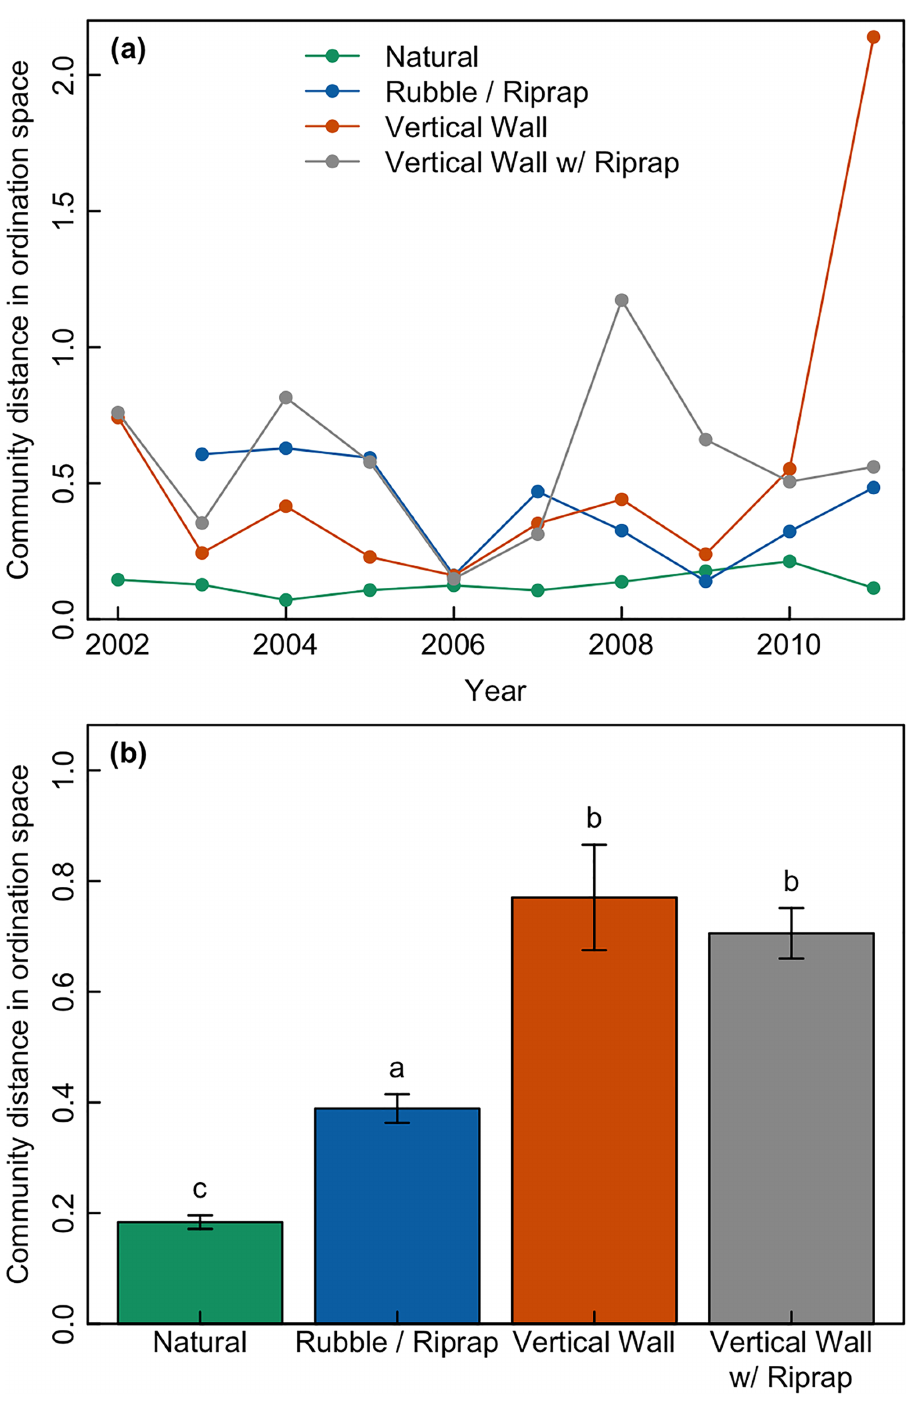
Fig 2. Fish community dissimilarity by shoreline type. Community dissimilarity measured by computing the Euclidean distance in (nMDS) ordination space between mean annual fish community structure observed in all pairs of years for each shoreline type (a). Mean Euclidian distance between fish community structure observed in all pairs of years for each shoreline type (+/- standard error of the mean) (b). Different letters indicate statistically significant differences based on ANOVA and post hoc pairwise comparisons using Tukey-Kramer ’ s HSD.